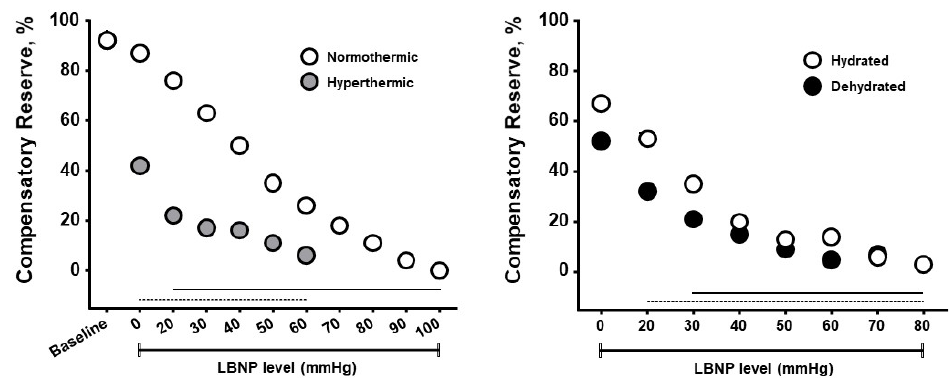
Figure 6. Compensatory reserve measures for normothermic vs hyperthermic subjects ( left ) and euhydrated vs dehydrated subjects ( right ) during progressive lower body negative pressure (LBNP) experiments. Data are means and 95% confidence intervals, with the solid lines at the bottom indicating statistically significant differences from baseline. Image modified from [13].